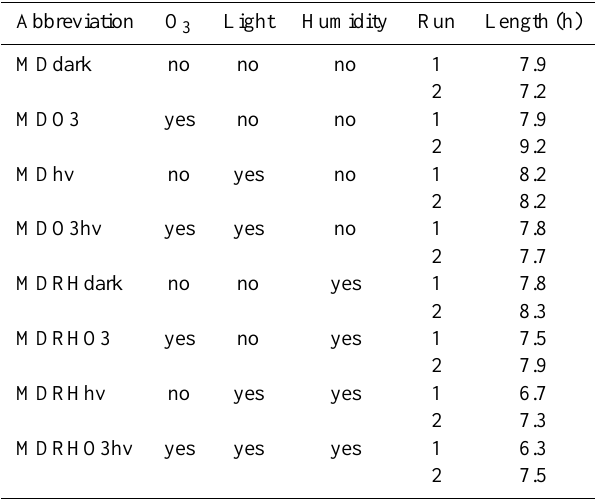
Table 2. Experiments to investigate isotopic fractionation during oxidation of SO 2 on the surface of mineral